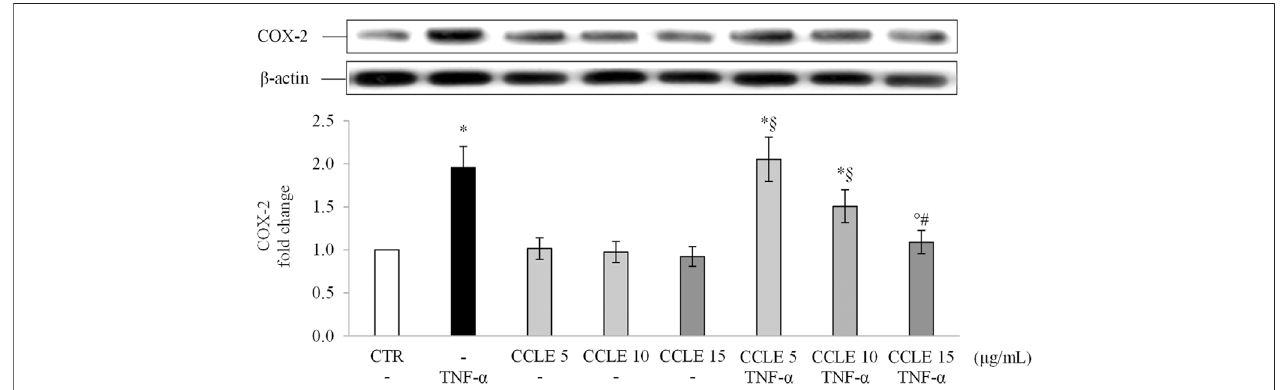
FIGURE 4 | COX-2 protein expression. The Caco-2 monolayer was pretreated with CCLE (5, 10, and 15 μ g/ml) for 24 h, and subsequently exposed to 50 ng/ml TNF- α for 6 h. Cultures treated with the vehiclesalone were used as controls (CTR). Caco-2 whole cell lysates were analyzed by Western blot, and the expression of the COX-2proteinwasevaluated.ResultsarereportedasfoldchangeagainstCTRandexpressed asmean±SDofthreeindependentexperiments.COX-2intensityvalues were normalized to the corresponding β -actin value. * p < .05 vs CTR; ° p < .05 vs TNF- α ; § p < .05 vs all doses of CCLE alone; # p < .05 vs lower doses of CCLE + TNF- α .